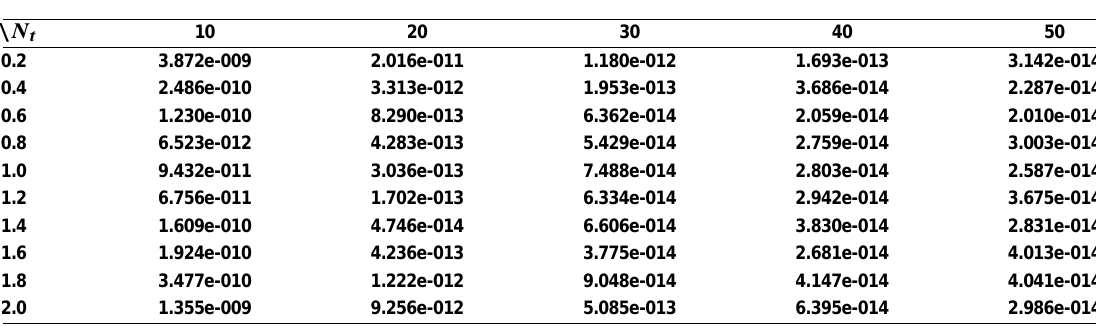
Table 4. Maximum errors E N for Fitzhugh-Nagumo when ˛ = 1 using N x D